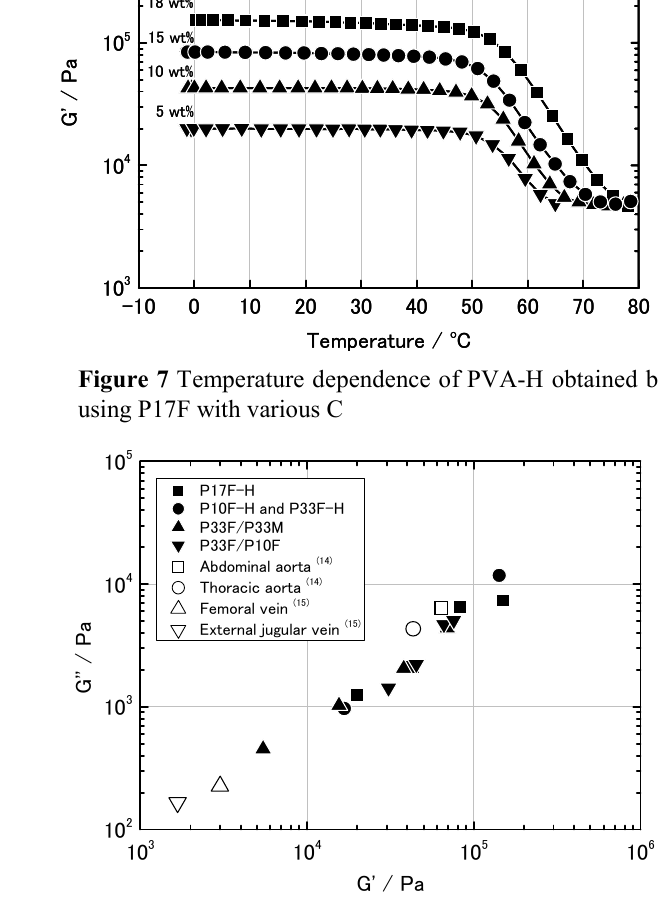
Figure 8 Comparison of the dynamic viscoelasticity of PVA-H with that of a dog blood